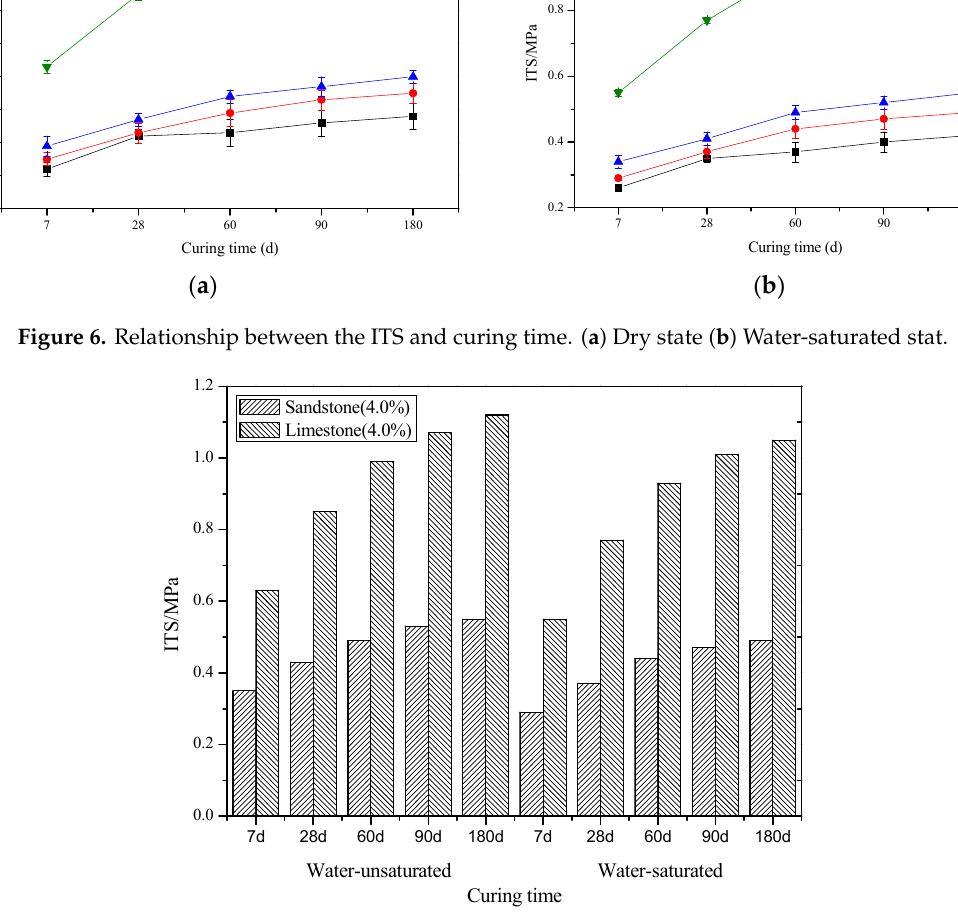
Figure 7. Relationship between the ITS and aggregate type.